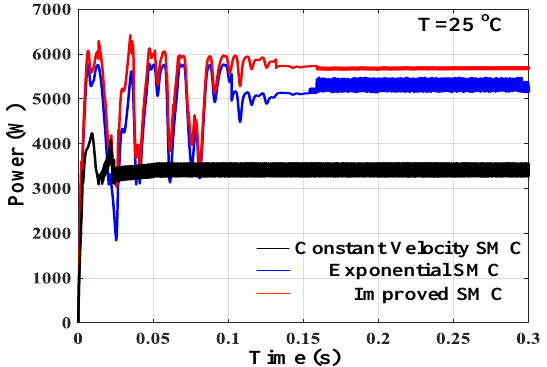
Figure 18. MPPT curve at PSC.